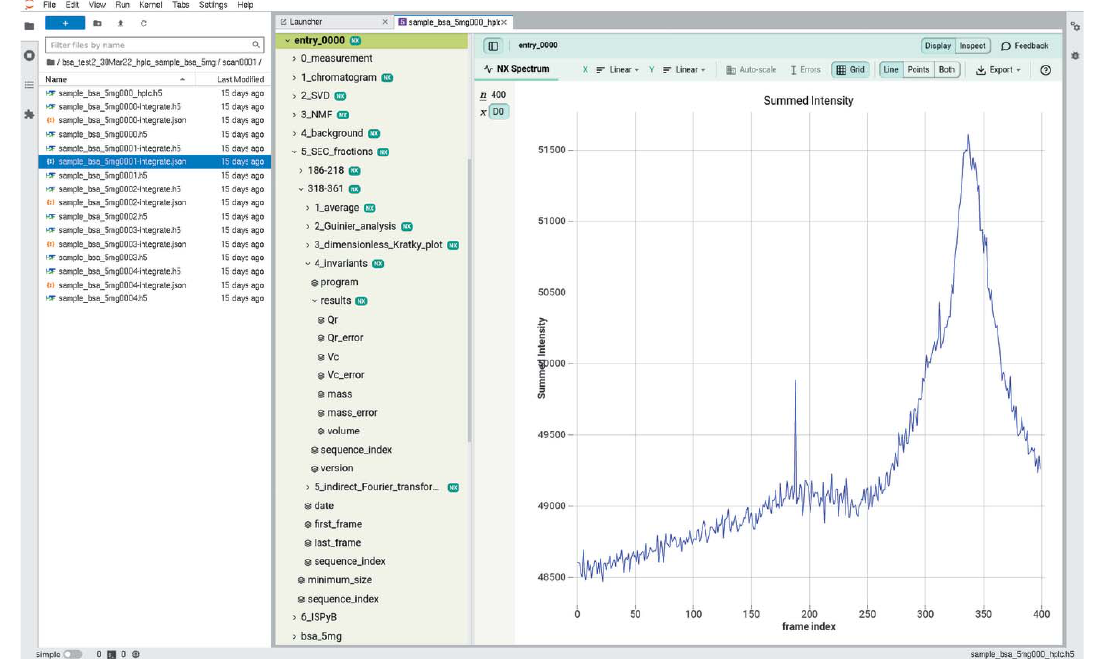
Figure 9 Default visualization of the HDF5 file produced by the HPLC pipeline with the h5web viewer integrated into JupyterLab